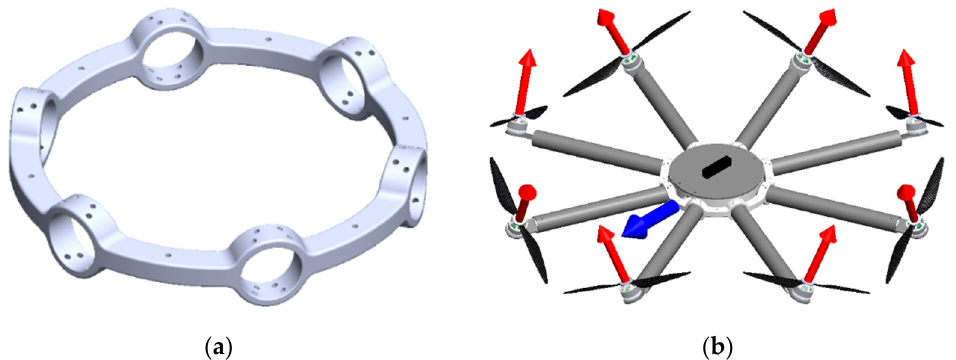
Figure 11. Propulsion module outer ring: ( a ) Part model of the propulsion assembly for fully-actuated configuration with six rotors; ( b ) Assembly model of the propulsion subsystem for fully-actuated configuration with eight rotors.